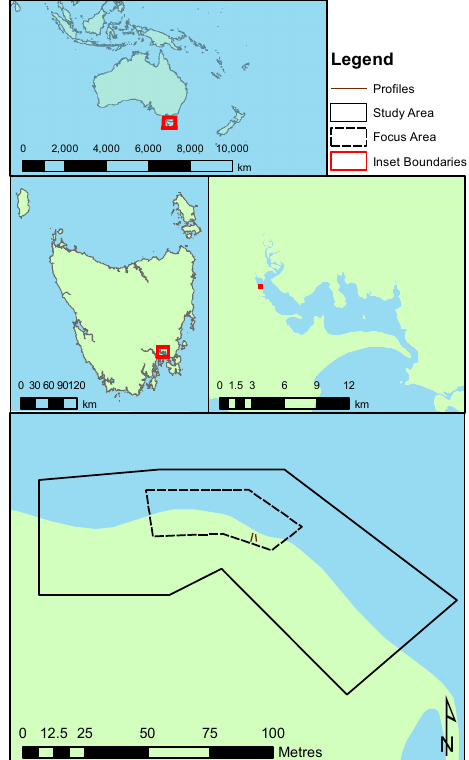
Figure 2: Coastal monitoring site.